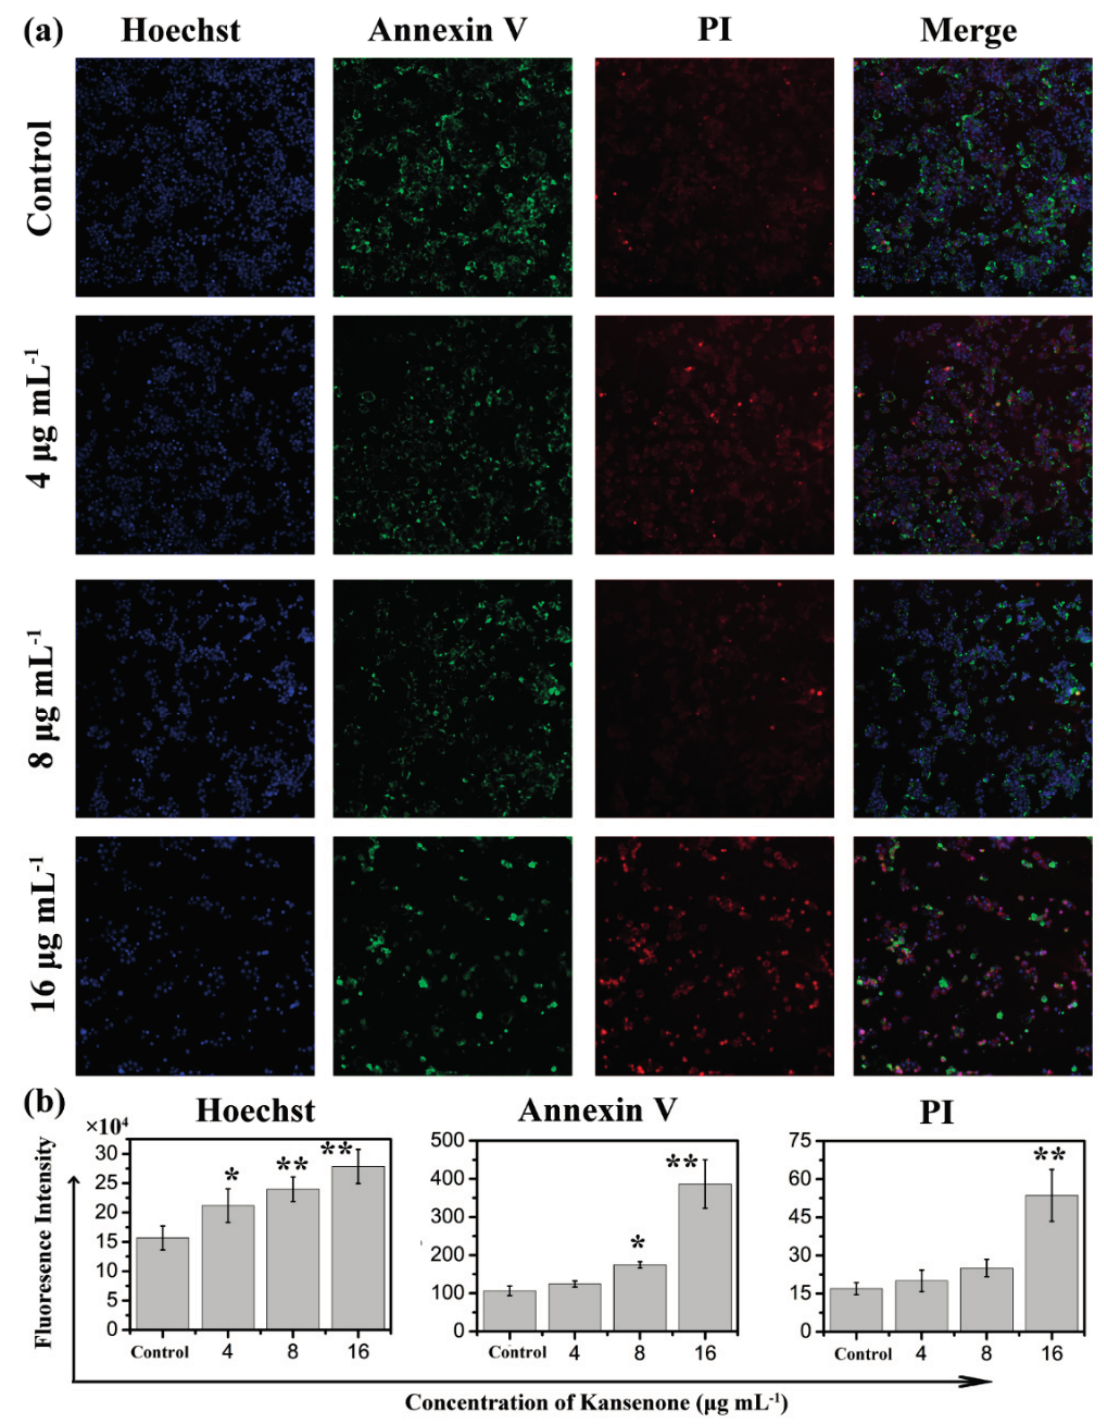
Figure 6. Confocal laser scanning microscopy (CLSM) images of IEC-6 cells incubated with Hoechst 33342/Annexin V-FITC/PI under a magnification of 100. ( a ) and the fluorescence intensity analysis after IEC cells incubated with Hoechst 33342/Annexin V-FITC/PI ( b ). Compared with corresponding control group, * p < 0.05, ** p <